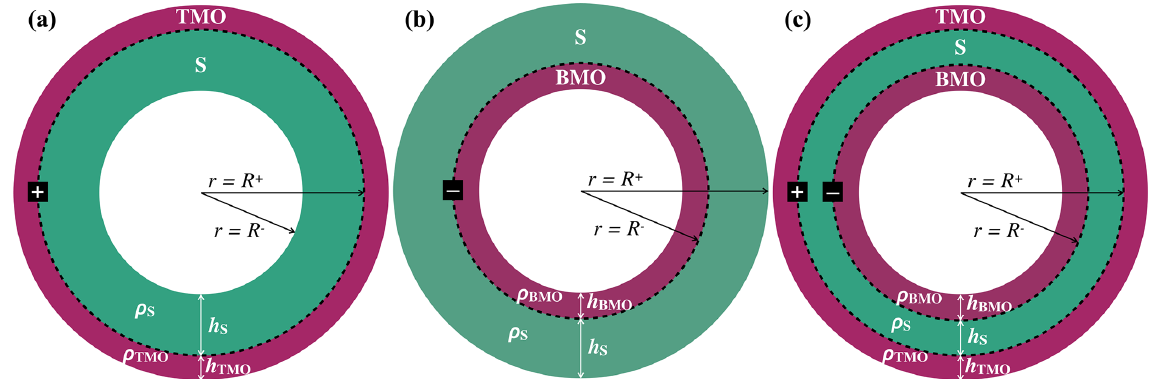
Figure 2. Sketches of three possible evolution scenarios: solid mantle (S) bounded by a (a) top magma ocean (TMO), (b) basal magma ocean (BMO), and (c) TMO and BMO. Solid mantle is taken as a spherical shell with density ρ S , thickness h S , inner radius R − , and outer radius R + . TMO and BMO are taken with respective densities of ρ TMO and ρ BMO and respective thicknesses of h TMO and h BMO . Superscripts “ + ” and “ − ” at the boundaries refer to the boundary between the TMO and the solid mantle and the boundary between the solid mantle and the BMO respectively. Table 1. Parameters used in the simulations. Parameter (dimension) Symbol Value Radius of the core–mantle boundary (km) R CMB 3480 Total radius of the planet (km) R P 6370 2890